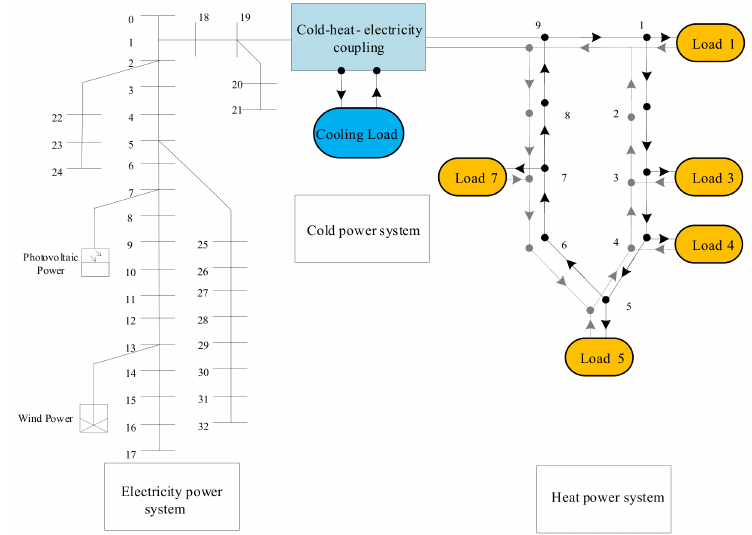
Figure 2. Topology of distributed energy system considering